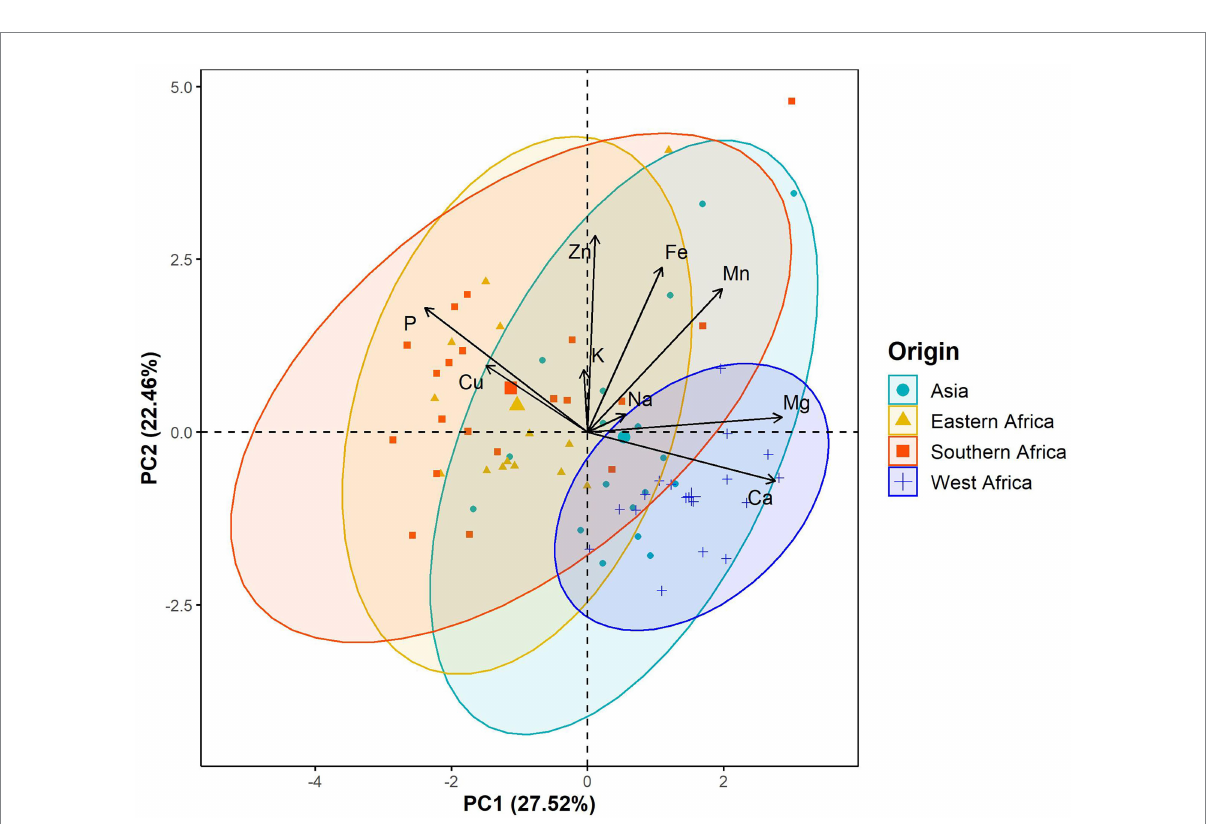
FIGURE 5 Biplots of the first principal component (PC1) versus the second principal component (PC2) for the leaf elemental composition in a population of 70 advanced lines of G. gynandra . Ninety percent bivariate ellipses were represented for lines from the same geographical origin. Asia ( n = 18), Eastern Africa ( n = 14), Southern Africa ( n = 20); and West Africa ( n =